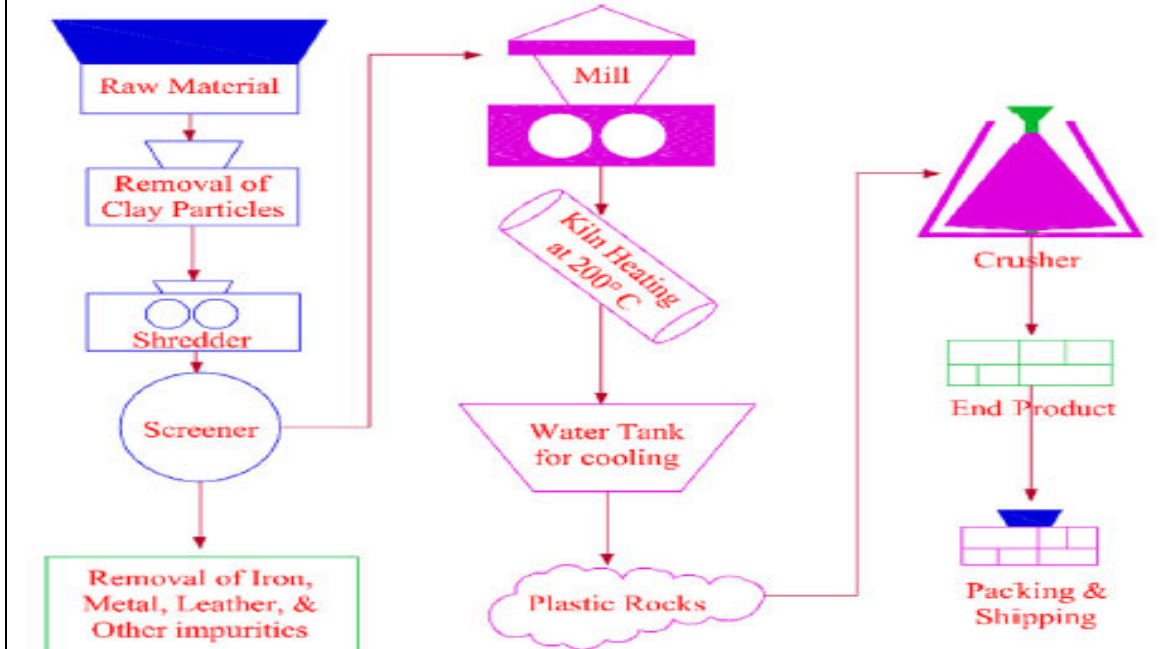
Figure 3. Manufacturing Process of Plastic Aggregates: Used as per Elsevier Permission [24].